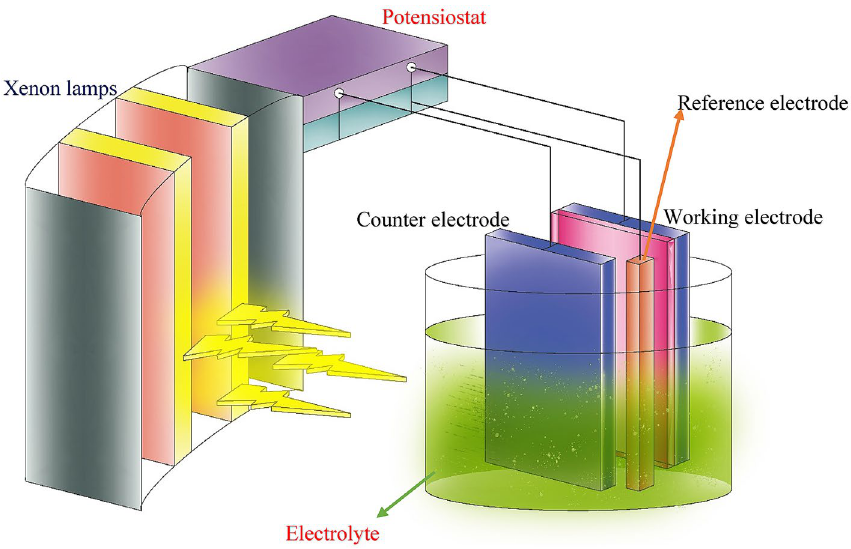
Figure 2. Schematic of photoelectrochemical